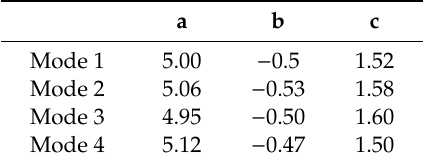
Table 2. Parameter values of di ff erent output modes in numerical